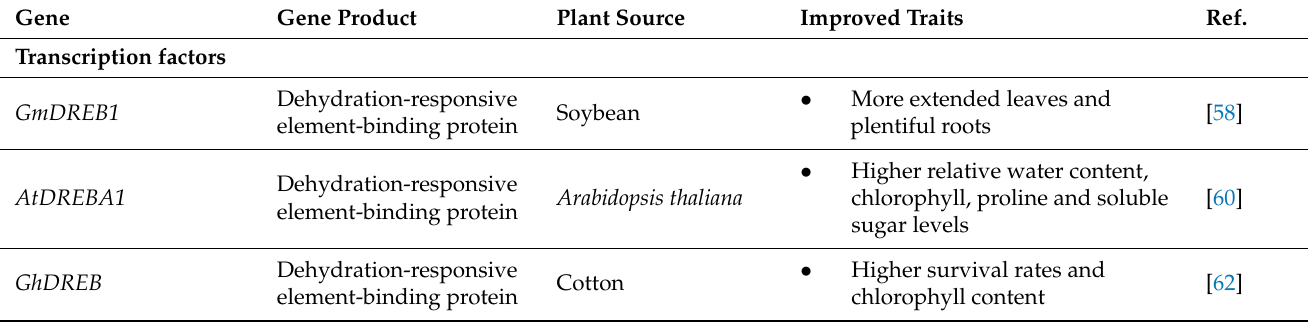
Table 2. Improvement of salinity tolerance in wheat plants through transgenic